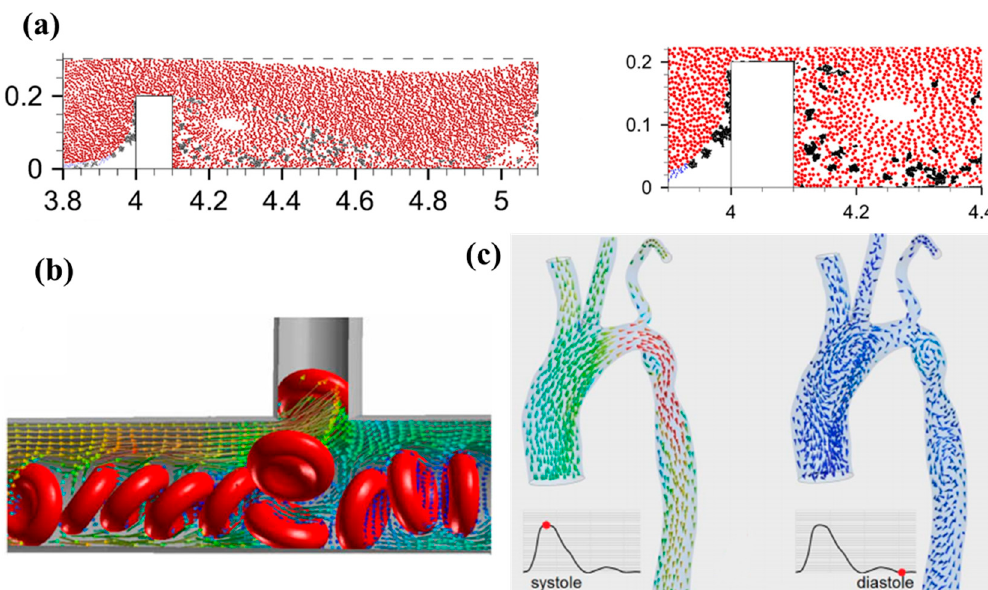
Figure 5. A few examples of past CFD simulations of phenomena in arteries. ( a ) Cell location distribution under the effects of a strut with a close-up view to the right. RBCs (Red) and activated and inactivated platelets (black and blue respectively) [75]. ( b ) Streamlines and velocity field of RBCs in the capillary [82] . ( c ) Velocity vector field during systole and diastole phases [83].